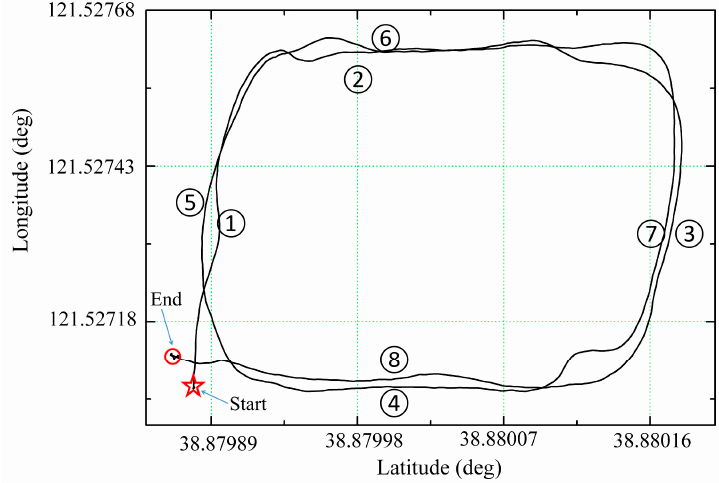
Figure 7. The flight path of flying quad-rotor UAV.